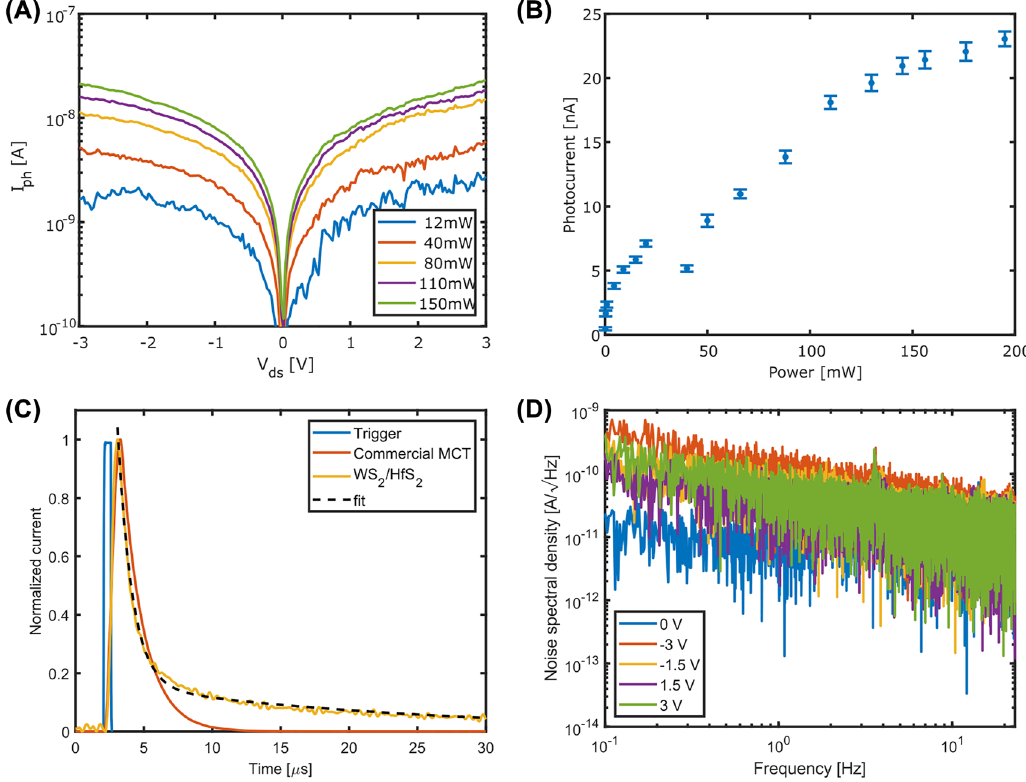
/HfS photodetector. (A) Measured I – V curves for different optical powers at 4.34 μ m Figure 3: Photocurrent and time response of a WS 2 2 wavelength. (B) Measured photocurrent as a function of optical input power. (C) Measured time response of the device compared to a commercial MCT photodetector. The trigger curve shows the duration of the laser pulse. (D) Measured noise spectral density as a function of frequency for different bias